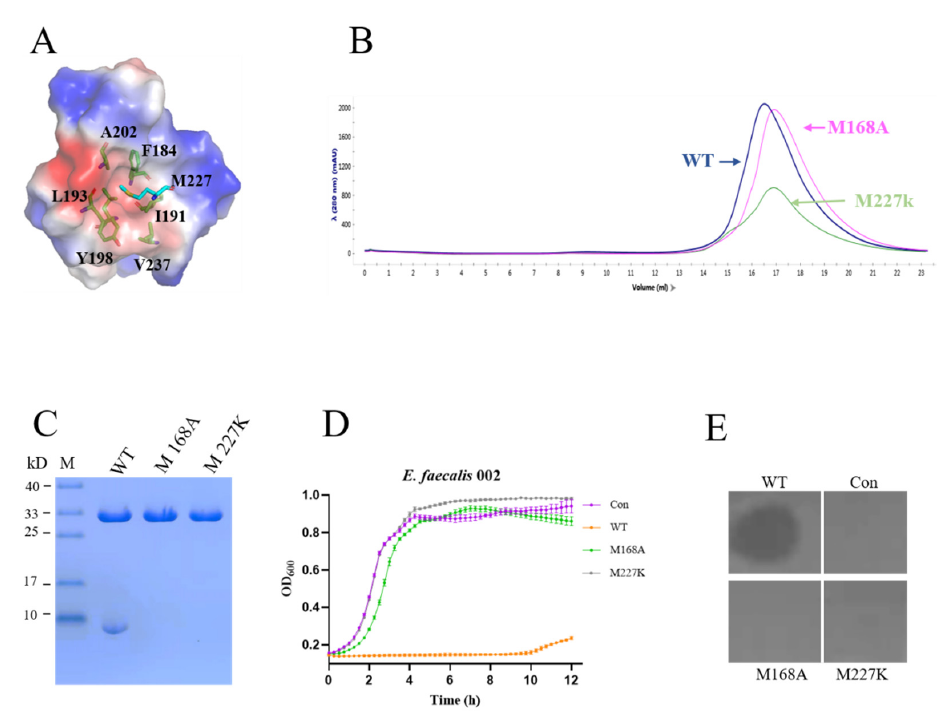
Figure 7. Lytic activity of the EFm1 tetramer. ( A ) Hydrophobic interactions between M227 and the nearby monome; ( B ) Size-exclusion chromatography of WT, M168A and M227K; ( C ) SDS-PAGE results of the mutants M168A and M227K, respectively; ( D ) Growth curves and plate lysis assay results of the mutants M168A and M227K, respectively; the mean ± s.e.m is shown; ( E ) Plate lysis assay results of the mutants M168A and M227K, respectively.